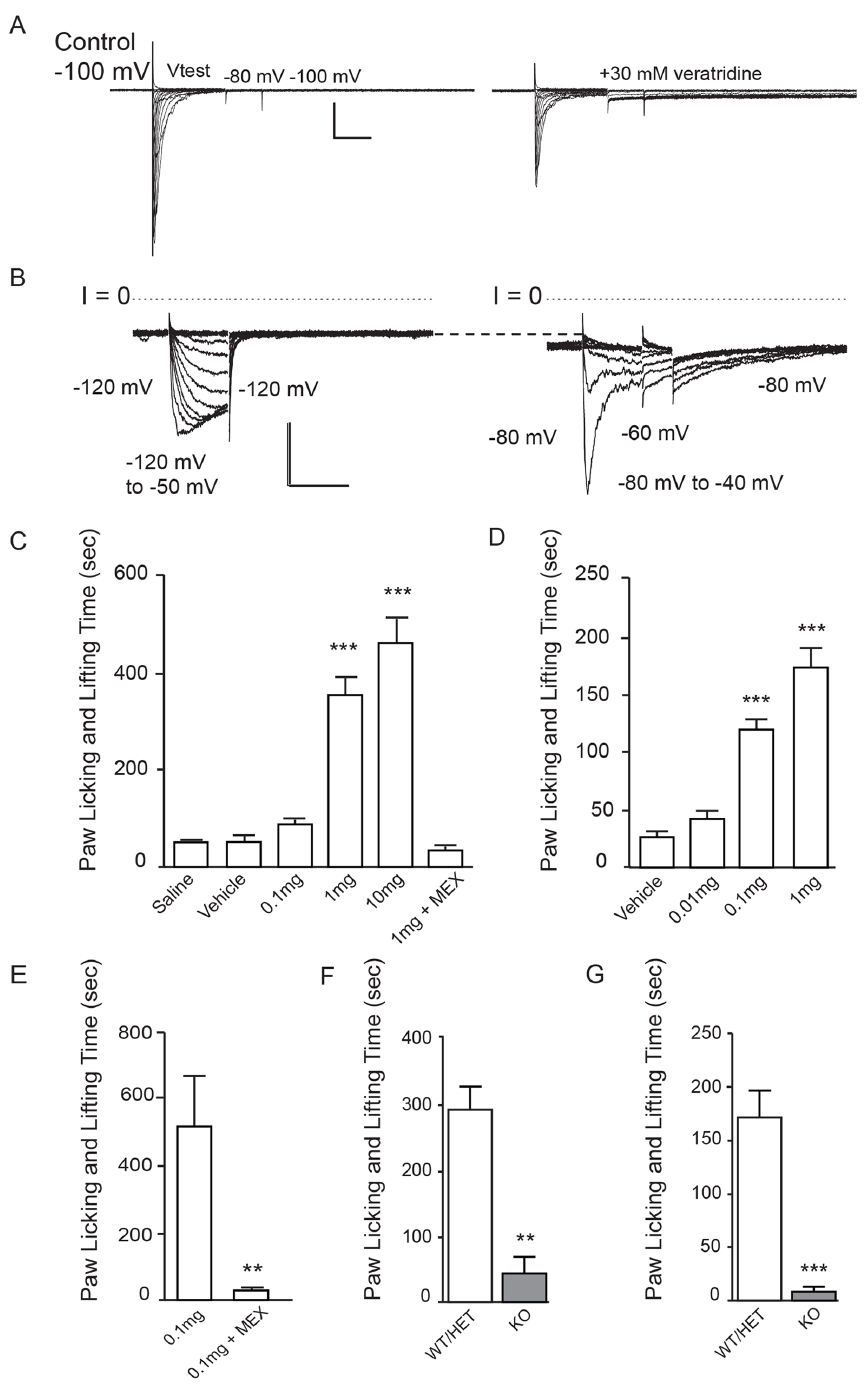
Figure 7. Nav1.7 KOs show minimal pain behaviors upon injection of veratridine or grayanotoxin III. A. hNav1.7 currents recorded from HEK 293 cells in control (left) and after addition of 30 m M veratridine (right). Currents were evoked by a family (traces overlaid) of depolarizing voltage pulses incremented by + 10 mV from a holding voltage of 2 100 mV, with repolarization to 2 80 mV followed by return to the holding voltage of 2 100 mV. Inward currents were evoked by depolarizations to 2 50 mV and more positive. Note the prolonged opening following repolarization in veratridine. Scale bars, 500 pA and 10 ms. B. Nav1.7 currents recorded with 300 m M grayanotoxin III in the internal (pipette) solution. Currents shown at left are in response to a family (traces overlaid) of step depolarizations in + 5 mV increments from 2 120 mV to 2 50 mV, followed by repolarization to 2 120 mV. Depolarizations to 2 95 mV and more positive evoked inward currents, and these currents showed little or no inactivation during the test pulse. Dotted line marks the zero current level (I=0). Currents shown at right are records from the same cell, after switching the holding voltage to 2 80 mV. Note that the holding current increased despite the decreased driving force (compare current at 2 80 mV to the dashed line marking the holding current at 2 120 mV), presumably reflecting steady influx of sodium ions through grayanotoxin-modified Nav1.7. Step depolarizations from 2 80 mV to 2 40 mV at + 10 mV increments evoked additional currents with slow inactivation and deactivation kinetics. Scale bars, 500 pA and 20 ms. C. Licking and lifting in male CD-1 mice in response to increasing intraplantar doses of veratridine. At doses of 1 m g and 10 m g, veratridine caused a